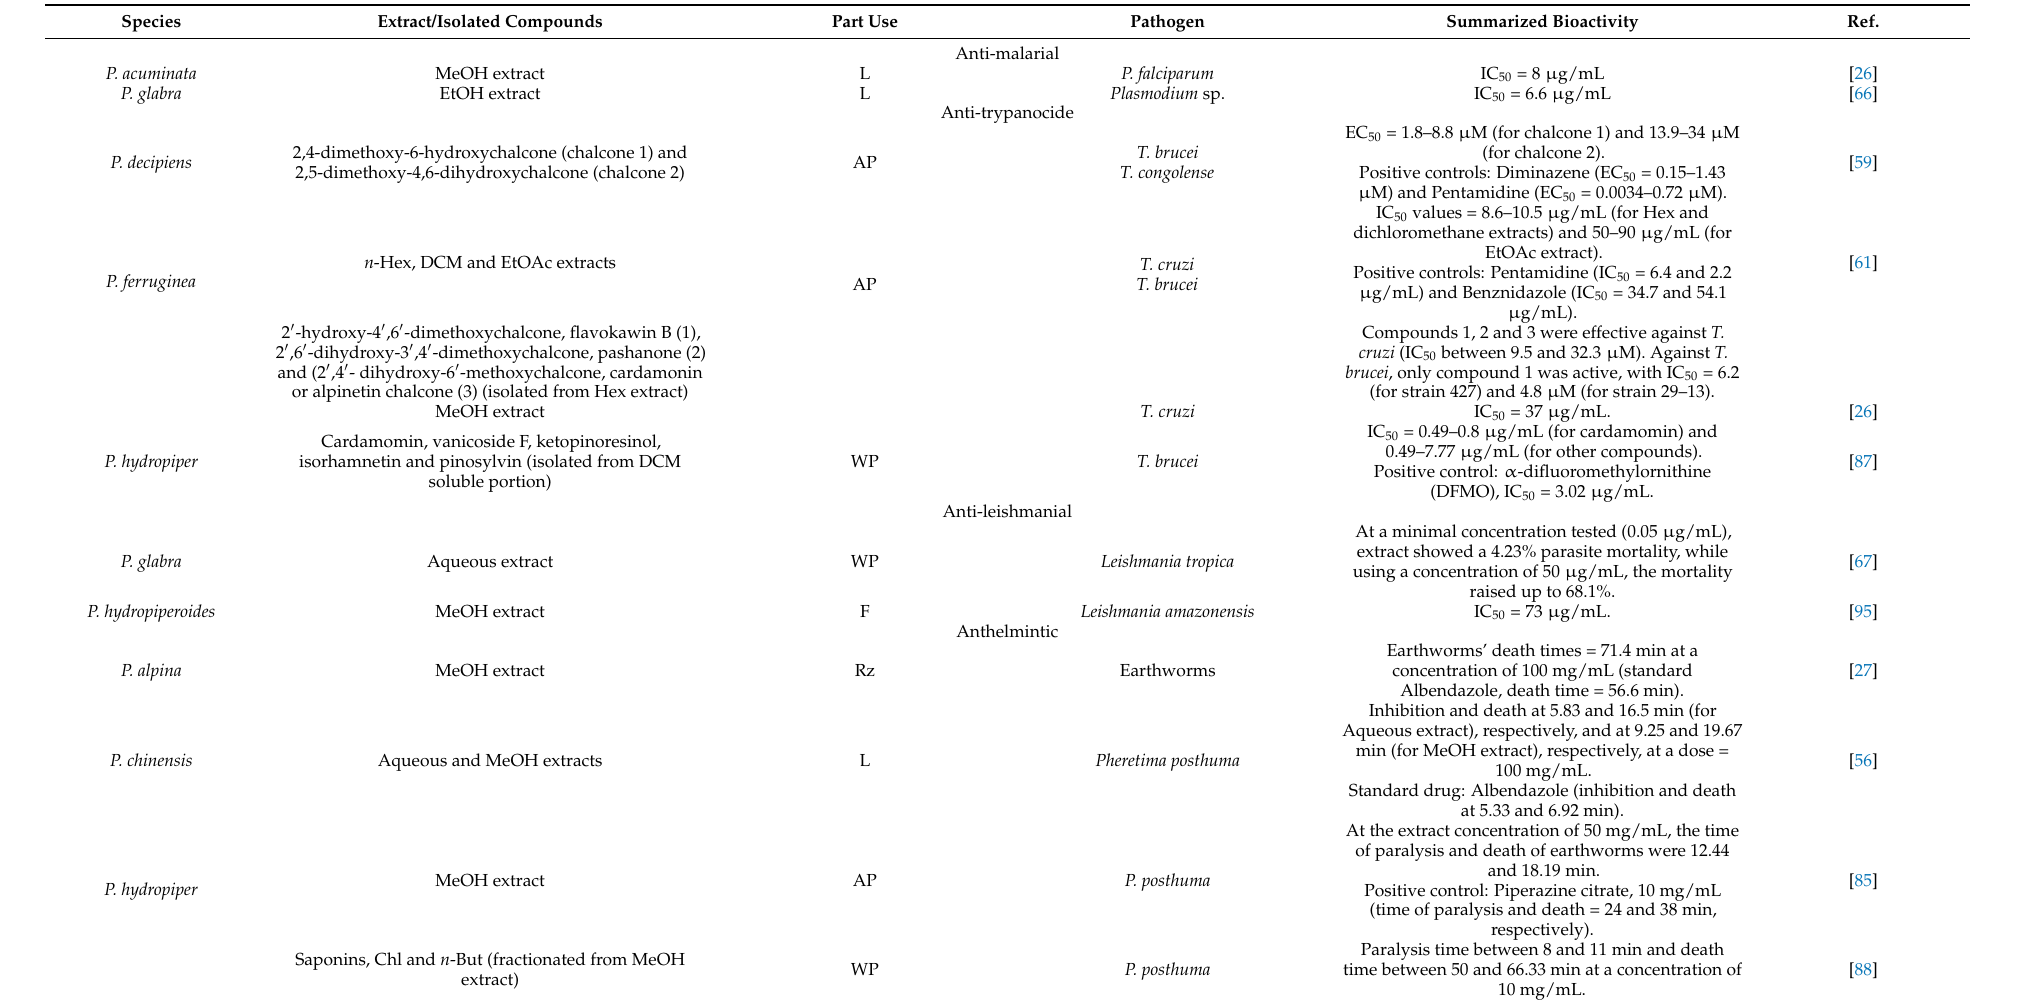
Table 7. Antiparasitic activities of Persicaria and Polygonum species. Extracts, compounds, part of the plant used, antiparasitic activity and references are shown. Extracts: EtOH (ethanol); MeOH (methanol); Hex (hexane); EtOAc (ethyl acetate). Part used: L (leaves); F (flowers); Fr (fruits); R (roots); Sp (sprouts); S (seeds); St (stems); Rz (rhizomes); T (tubers); B (barks); WP (whole plant); AP (aerial